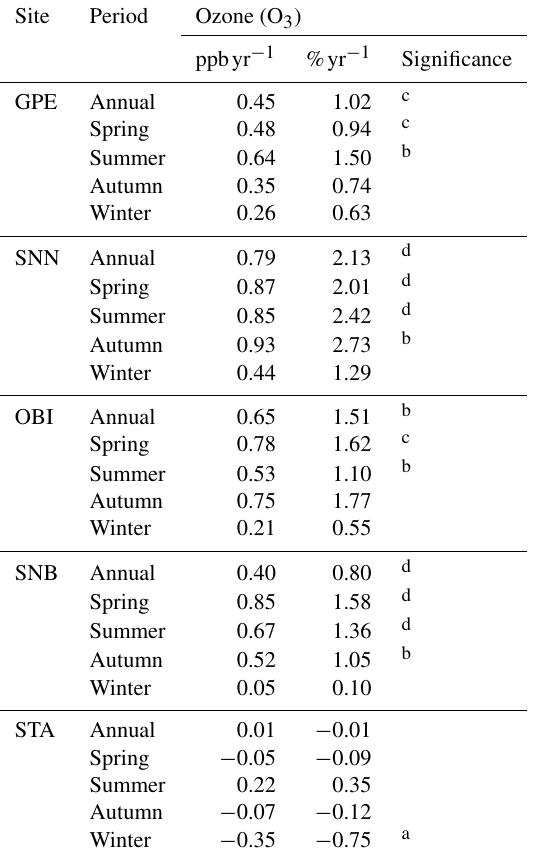
Table 5. Results for O 3 daily maximum long-term trends by season in ppbyr − 1 during 1993–2014 at the five sites within the MMA.